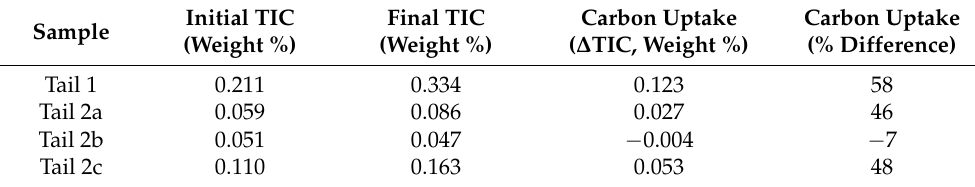
Table 9. Summary of change in TIC in disks of the Stillwater tailings.